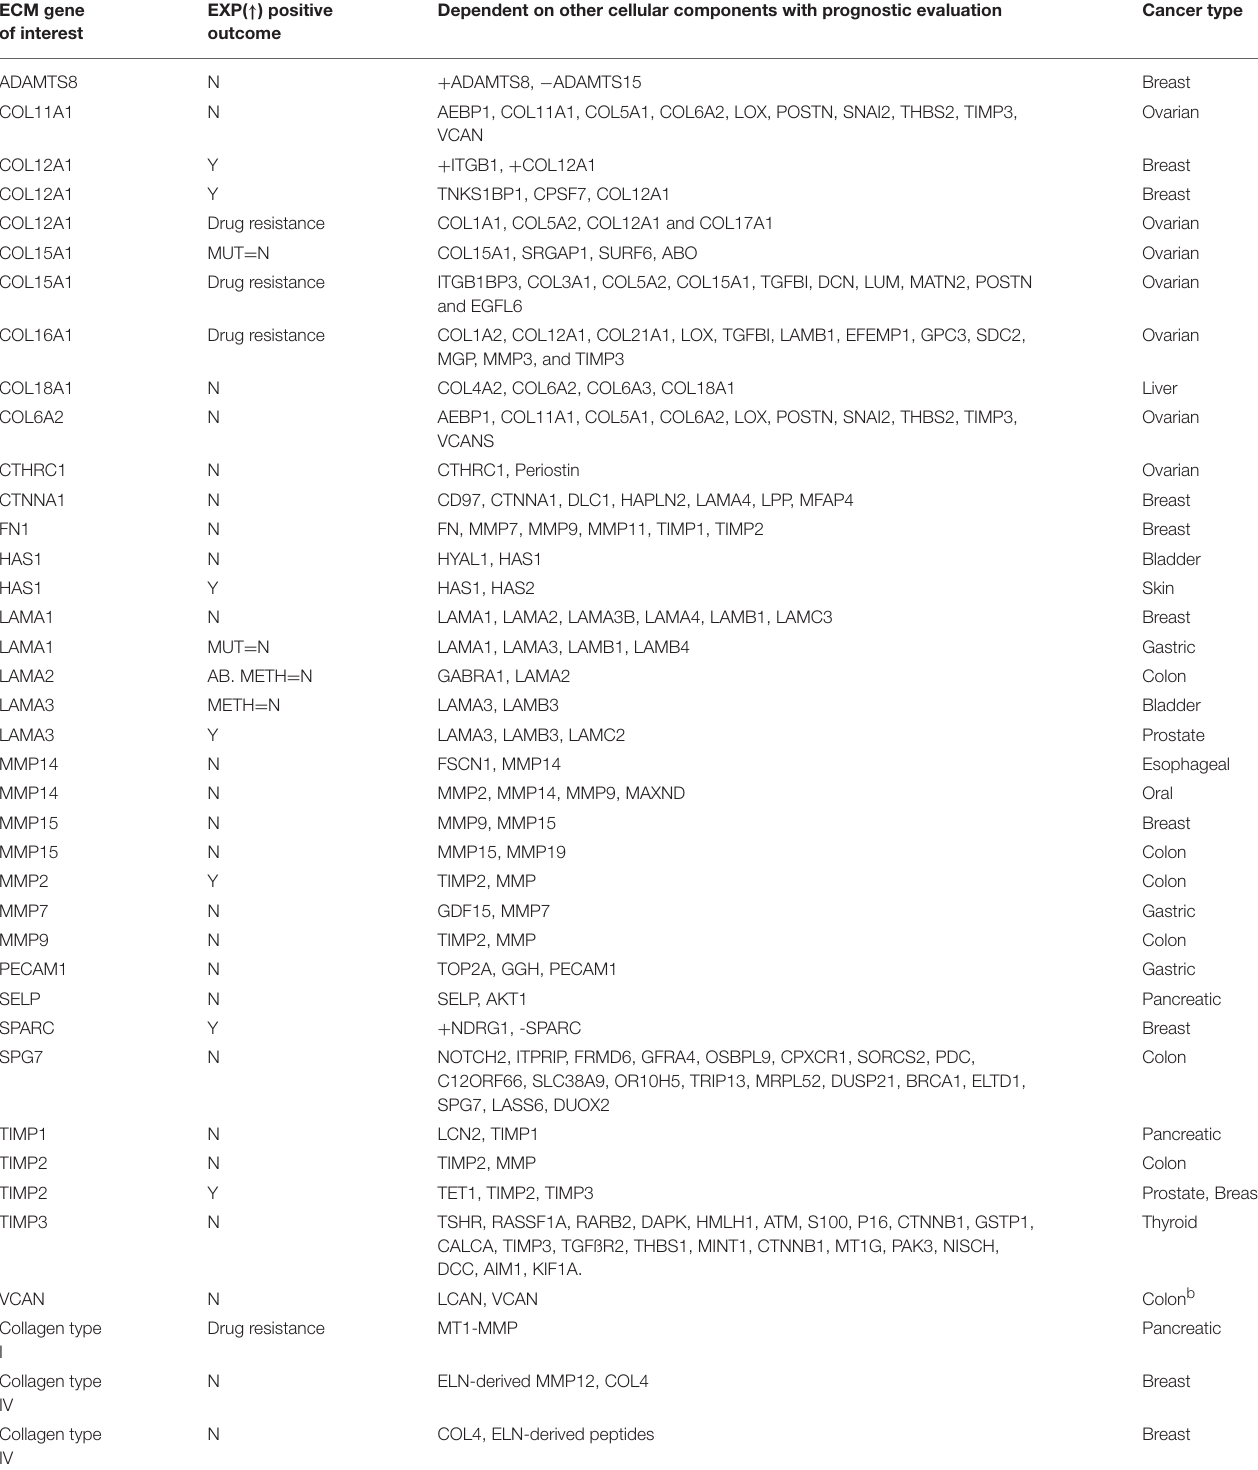
a Refer footnote from Table 1 . b EXP( ↑ ) Positive Outcome, positive expression of the ECM gene of interest correlates with a positive patient outcome; MUT, mutation; AB. METH, abnormal methylation; METH, methylation; ± , expression up/down required for predicted patient